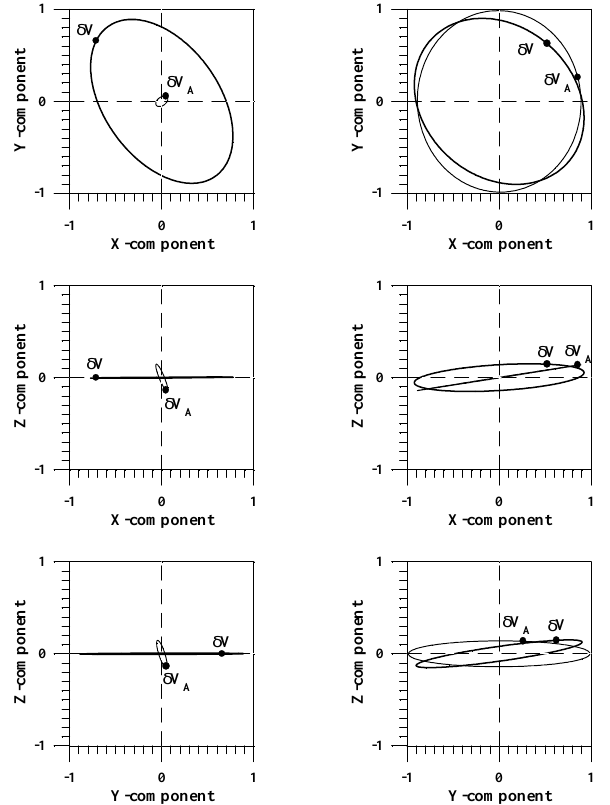
Fig. 13. Ratio of axis lengths for the polarisation ellipse of ve- locity and magnetic field perturbations, associated with the surface fast magnetoacoustic wave, versus the incident angle of the entropy wave setting the value c p . The left (right) plots show this ratio be- hind the front of fast (slow) shock